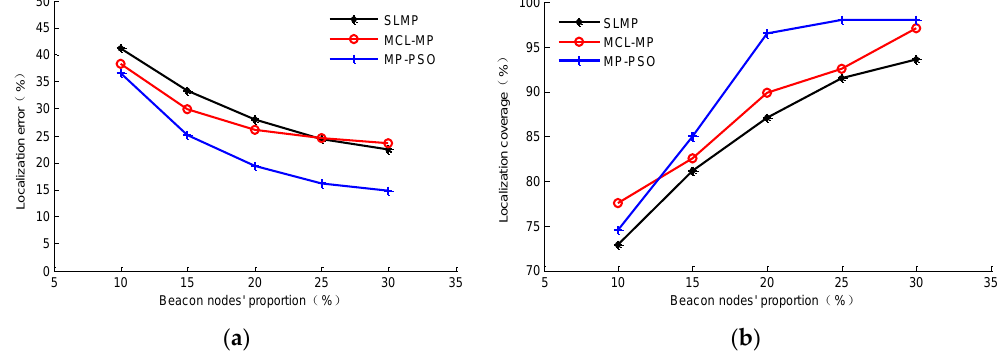
Figure 10. Impacts of the beacon node proportion on localization results: ( a ) on localization error; ( b ) on localization coverage.